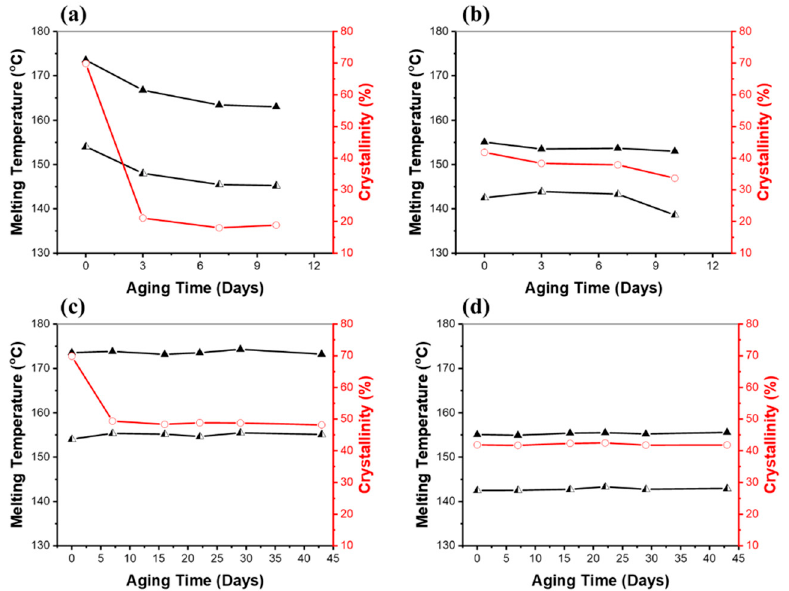
Figure 6. Melting temperatures ( (cid:78) , ◭ ) and the degrees of crystallinity ( O ) of ( a ) PHB and ( b ) PHBV after being aged in soil fully saturated with water (100% RH), and ( c ) PHB and ( d ) PHBV after being aged in soil with 40% RH. Values were determined from DSC runs. The degree of crystallinity was calculated by dividing the enthalpy of fusion determined by DSC by 146 J/g.